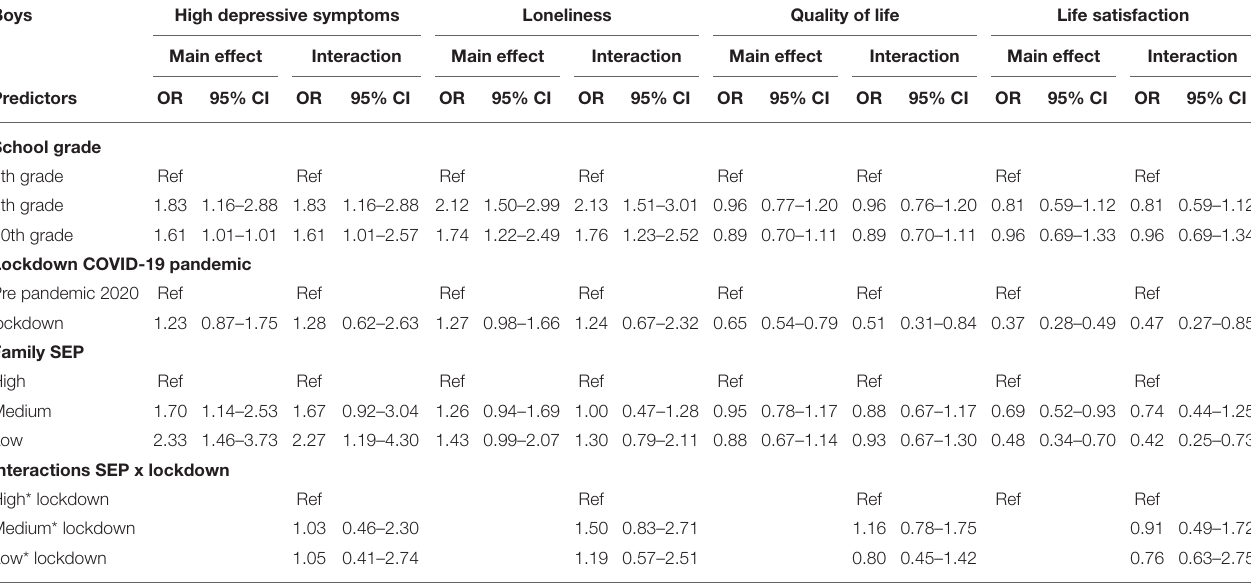
TABLE 2 | The impact of family SEP and lockdown during COVID-19 pandemic * , and its interaction on the probability of high level of depressive symptoms, loneliness, quality of life, and life satisfaction among boys in lower secondary education.